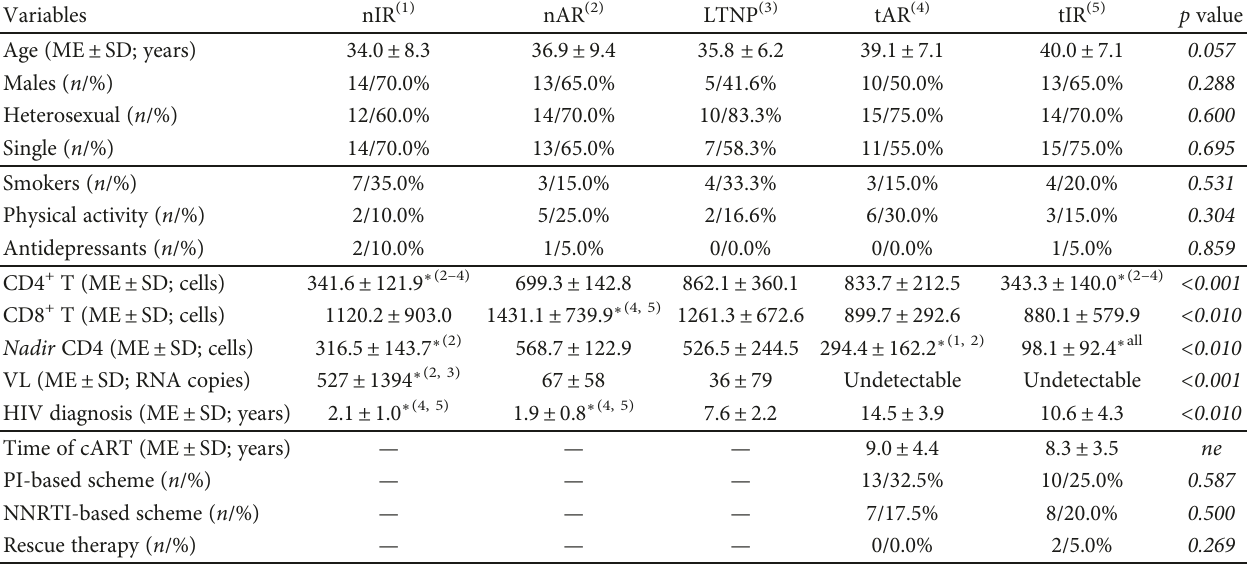
Table 1: Epidemiological and clinical characterization of 92 HIV-infected individuals